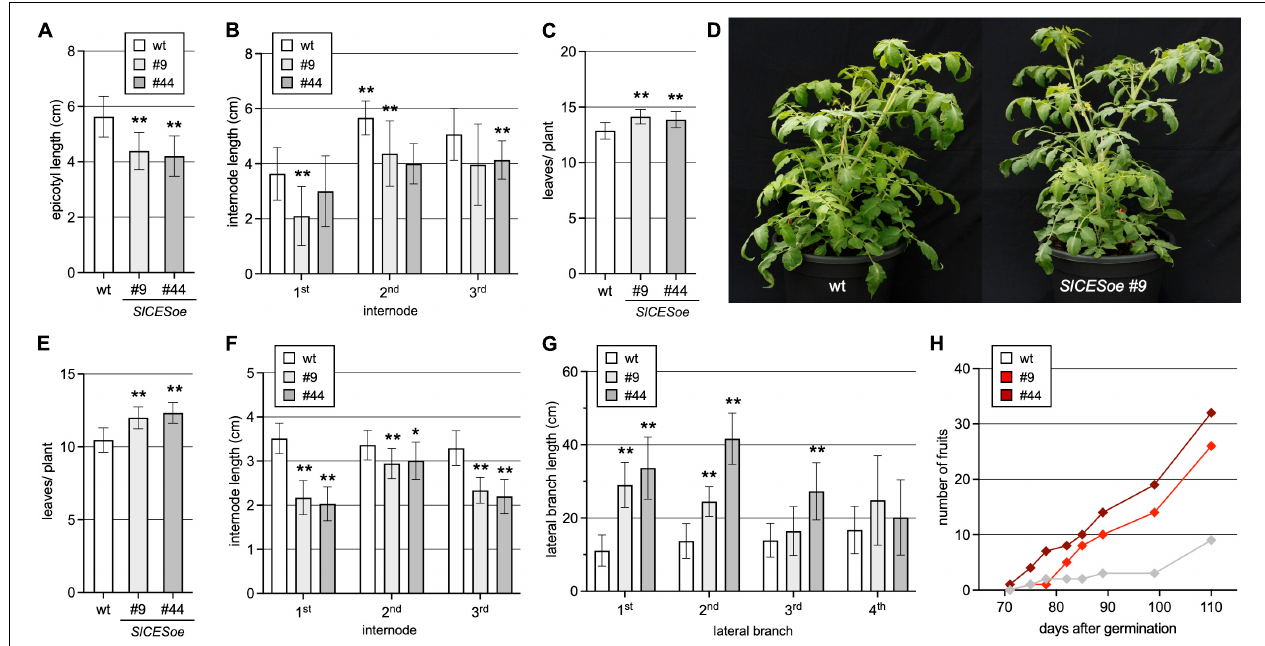
FIGURE 3 | Over-expression of SlCES promotes lateral branch growth and fruit set in low ambient temperatures. (A–D) SlCES over-expressing plants and wild-type at normal ambient temperatures of 25 ± 3 ◦ C. The plants were grown in soil, in long-day conditions in the greenhouse. Different growth parameters were assessed from 15 plants of each genotype, including epicotyl length after 5 weeks (A) , and the length of the first three internodes (B) and the number of leaves (C) after 8 weeks. Photos of representative plants at 7 weeks post germination are shown (D) . (E–H) SlCES over-expressing plants and wild-type at low ambient temperatures of 18 ± 3 ◦ C. The plants were grown at lower temperatures, but with otherwise comparable conditions as in panel (A–D) and the following growth parameters were assessed: leaves per plant (E) , the length of the first three internodes (F) and the length of the first 4 lateral branches (G) , all after 8 weeks of development. In addition, the total number of fruits that had developed at least to the green stage was counted at different stages of development from 15 plants per line (H) . The results in all bar charts are shown as means ± SD ( n = 15). (* P < 0.05; ** P < 0.01; Student’s t -test).